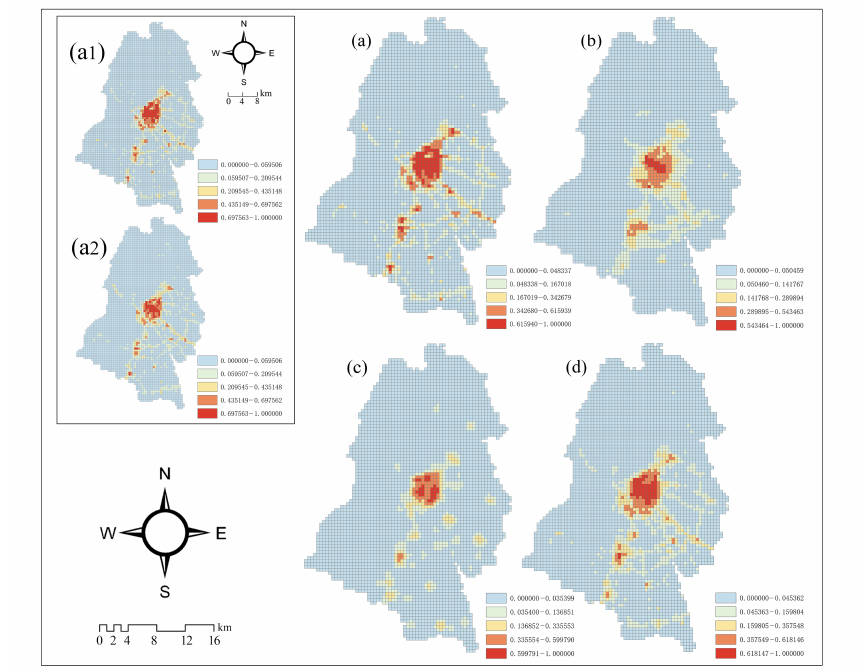
Figure 4. Spatial patterns of urban vibrancy in Dujiangyan. ( a ) Urban Social Vibrancy (USV). ( a1 ) Urban Social Vibrancy on weekdays (USV1). ( a2 ) Urban Social Vibrancy on weekends (USV2). ( b ) Urban Eco- nomic Vibrancy (UEV). ( c ) Urban Cultural Vibrancy (UCV). ( d ) Urban Comprehensive Vibrancy